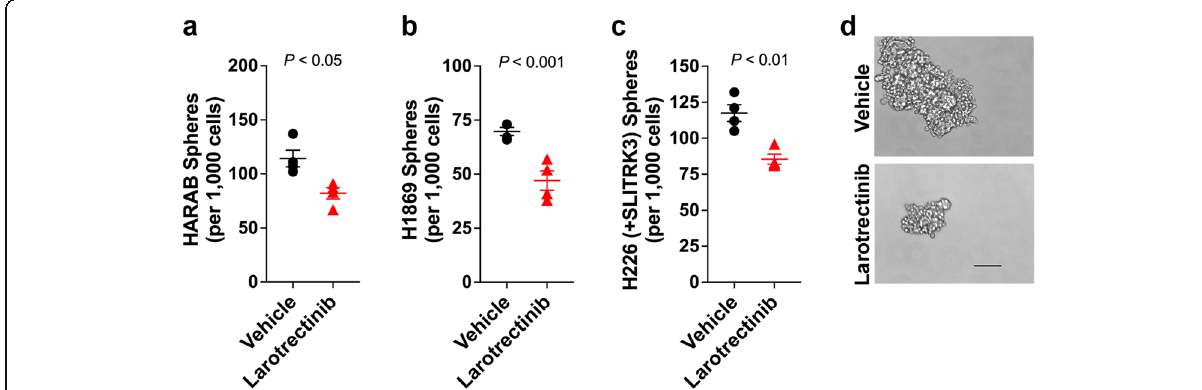
Fig. 6 A pan-NTRK SMKI inhibits CSCs. CSC sphere formation assays were performed on (a-b) HARAB and H1869 LUSC cell lines, each with endogenous SLITRK3 amplification, and (c) H226 cells transduced to overexpress SLITRK3. Cultures were treated with NTRK inhibitor larotrectinib (1 μ M) or vehicle. Lines, SEM. (d) Representative images of HARAB spheres, vehicle control and larotrectinib-treated (7days, 1 μ M). 20x magnification, Bar=100 μ